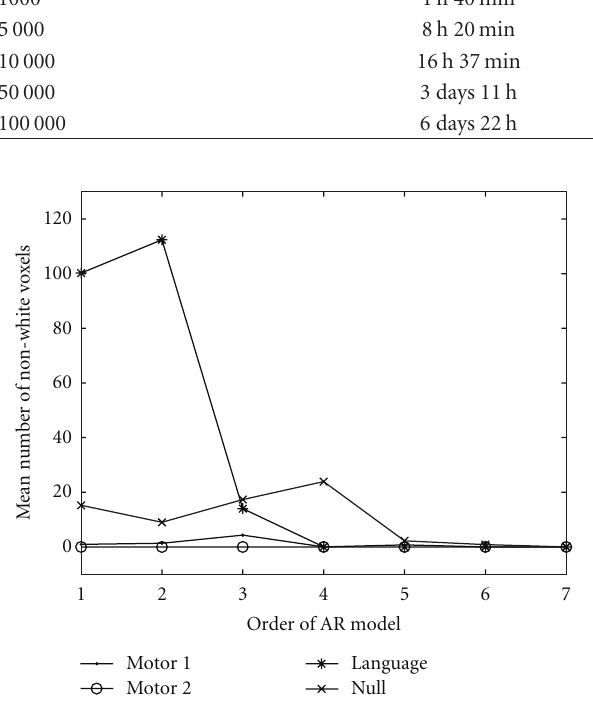
Table 3: Processing times for random permutation tests with 2D CCA for the di ff erent implementations. Number of permutations with 2D CCA